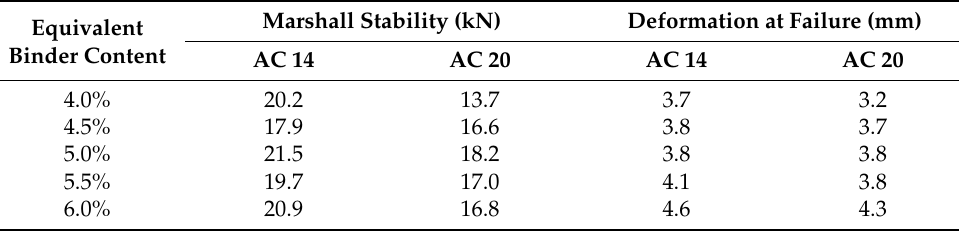
Table 9. Marshall stability and deformation results for selected mixtures with 75% SSA.